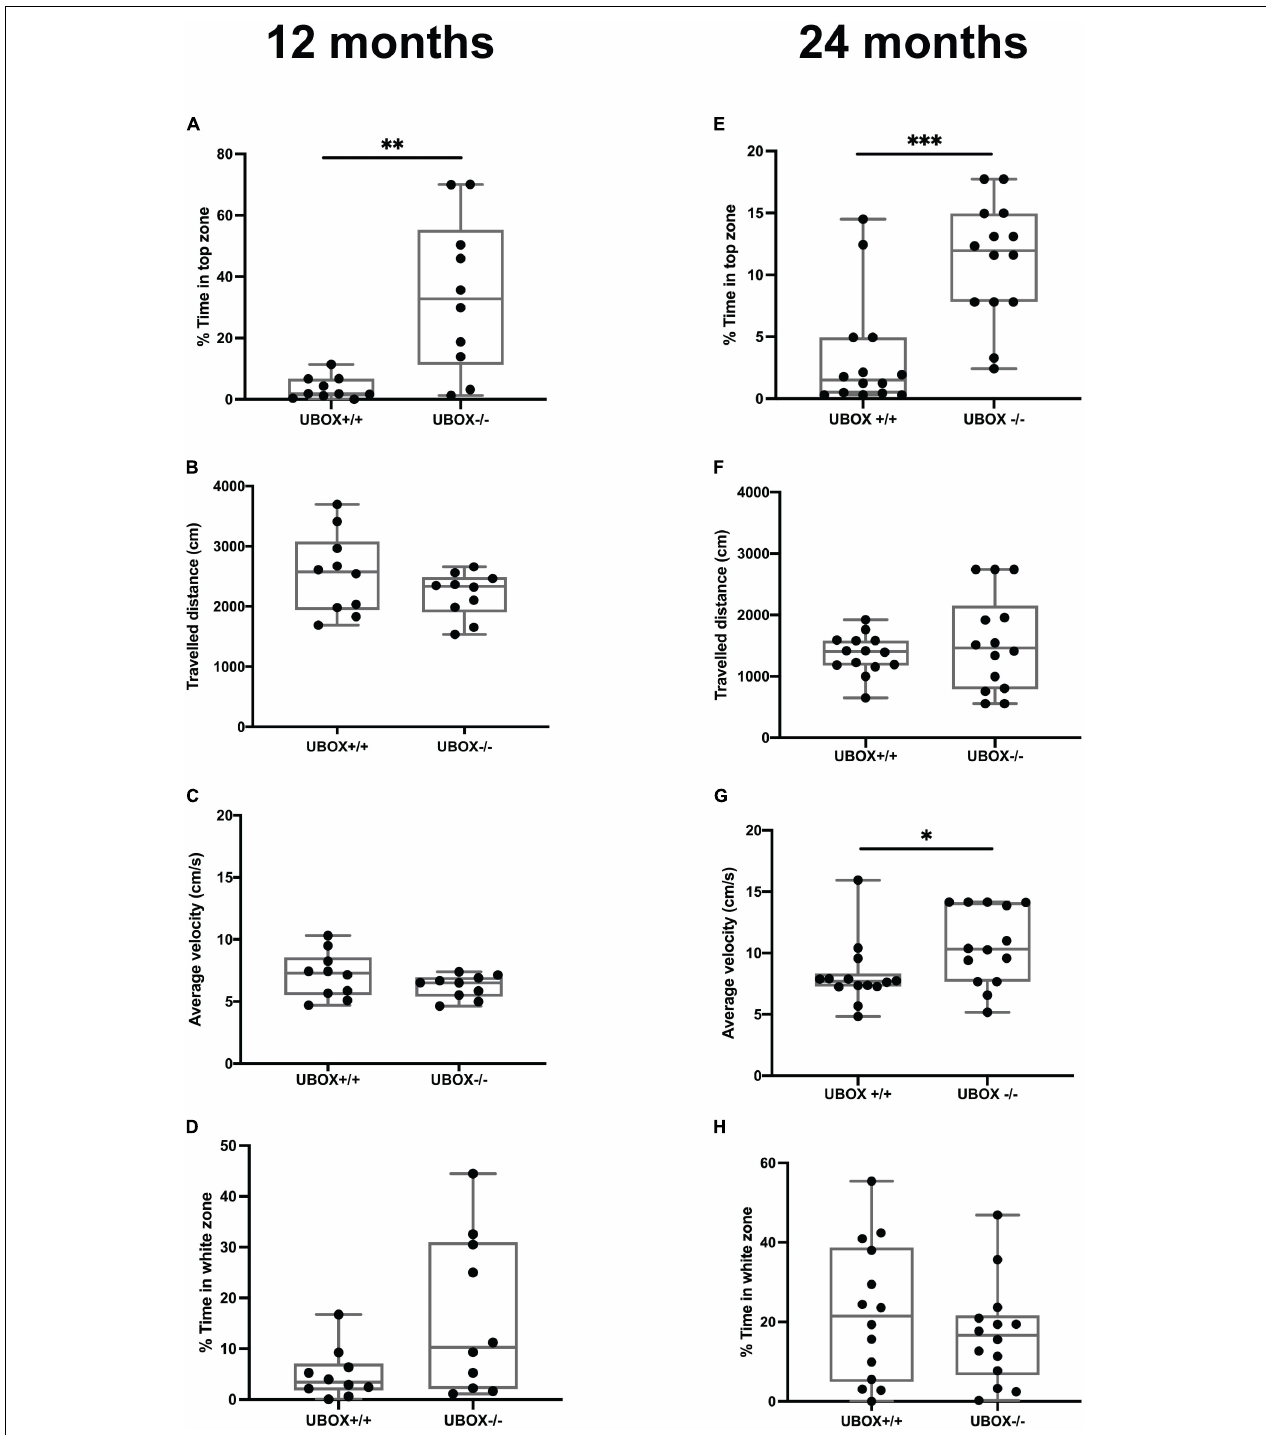
FIGURE 9 | U-box − / − fish exhibit less anxiety-like behavior compared to the wild-type fish. The anxiety-like behavior of wild-type and U-box − / − fish was measured by novel tank diving and light/dark preference tests. In the novel tank diving test, the fraction of time spent in the top third zone of the novel tank (A,E) , the distance traveled (B,F) , and average velocity (C,G) was quantified and compared for each genotype group ( n = 10–14 per group) at 12 (A–C) and 24 months (E–G) . In the light/dark preference test, the fraction of time spent in the white zone of the tank was quantified and compared for each group ( n = 10–14 per group) at 12 (D) and 24 (H) months. Data shown are the lower and upper quartiles (Q1–Q3) and the whiskers show range of values outside Q1-Q3. Statistically significant differences are shown by asterisks ( ∗ p < 0.05; ∗∗ p < 0.01; ∗∗∗ p < 0.001, Student’s t -test).